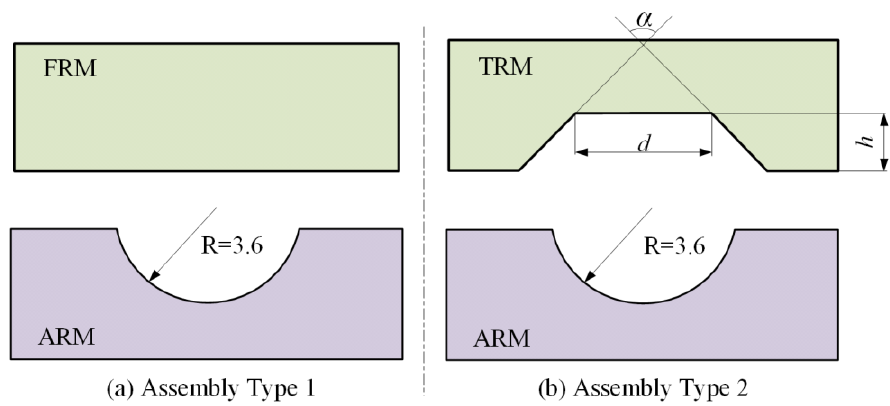
Figure 3. Different riveting mold assembly types: ( a ) FRM-ARM, ( b ) TRM-ARM.